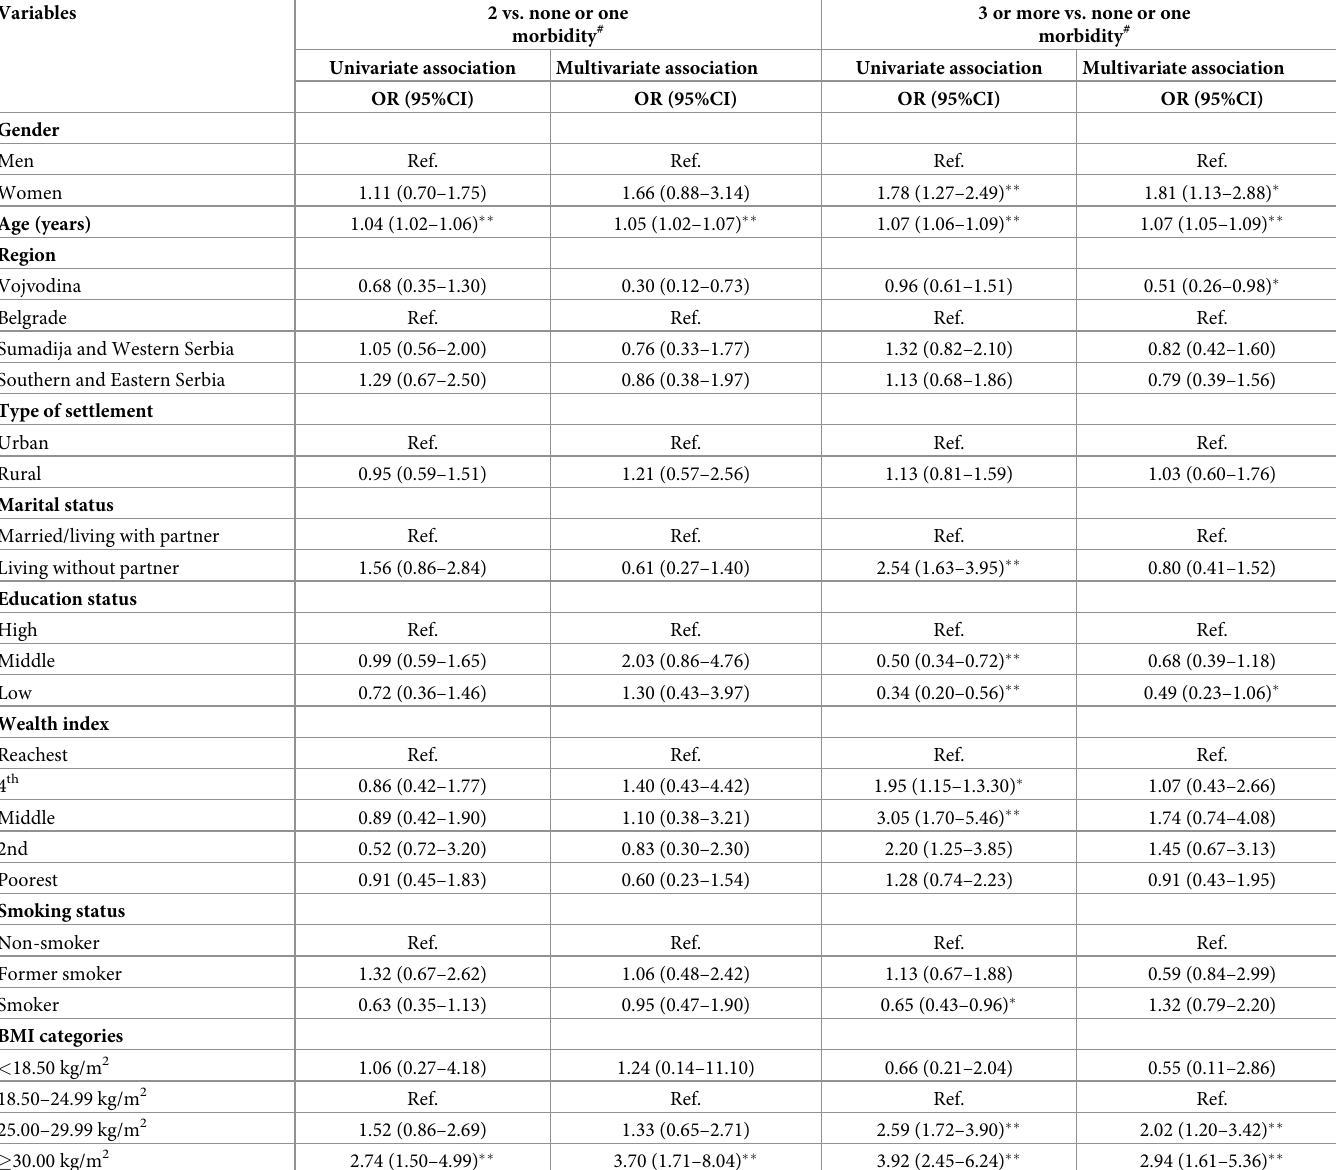
Table 6. Unadjusted and adjusted odds ratios for associations between socio-demographic, lifestyle variables and the number of morbidities in respondents who reported presence of kidney disease, Republic of Serbia, 2013.